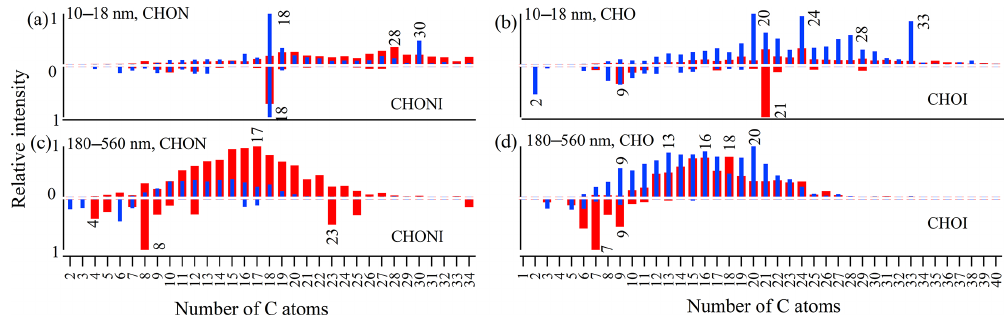
Figure 3. Relative intensities of subgroups according to C atom number in CHON, CHO, CHONI and CHOI formulas in 10–18 and 180– 560nm particles in ESI + (in red) and ESI − (in blue). The intensity of the most abundant subgroup in a size bin is defined as 1, and those of other subgroups are normalized by it. The relative intensities of non-iodinated OC formulas (iodinated OC formulas) are plotted in the region above (below) the zero